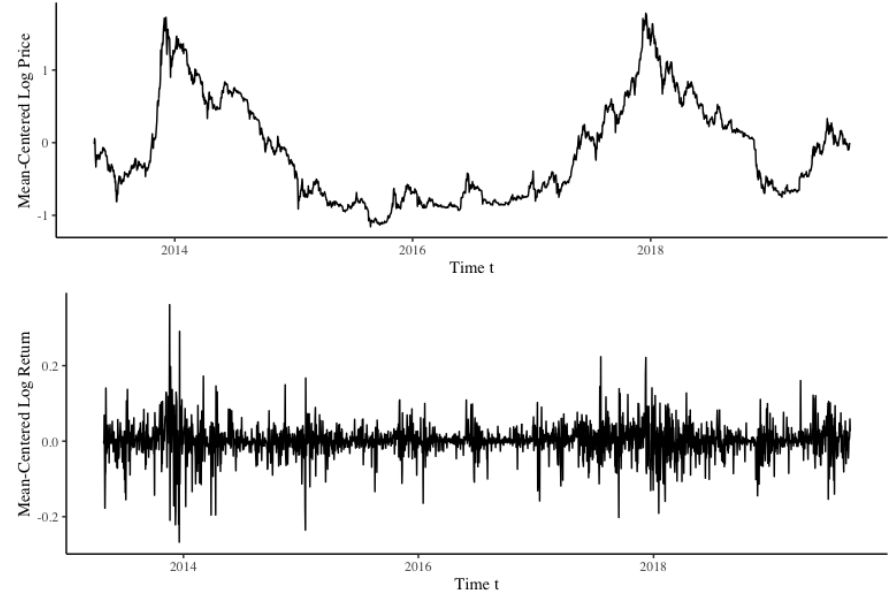
Figure 5. Daily mean-centered log Bitcoin open price process ( top ) and mean-centered log returns process ( bottom ).